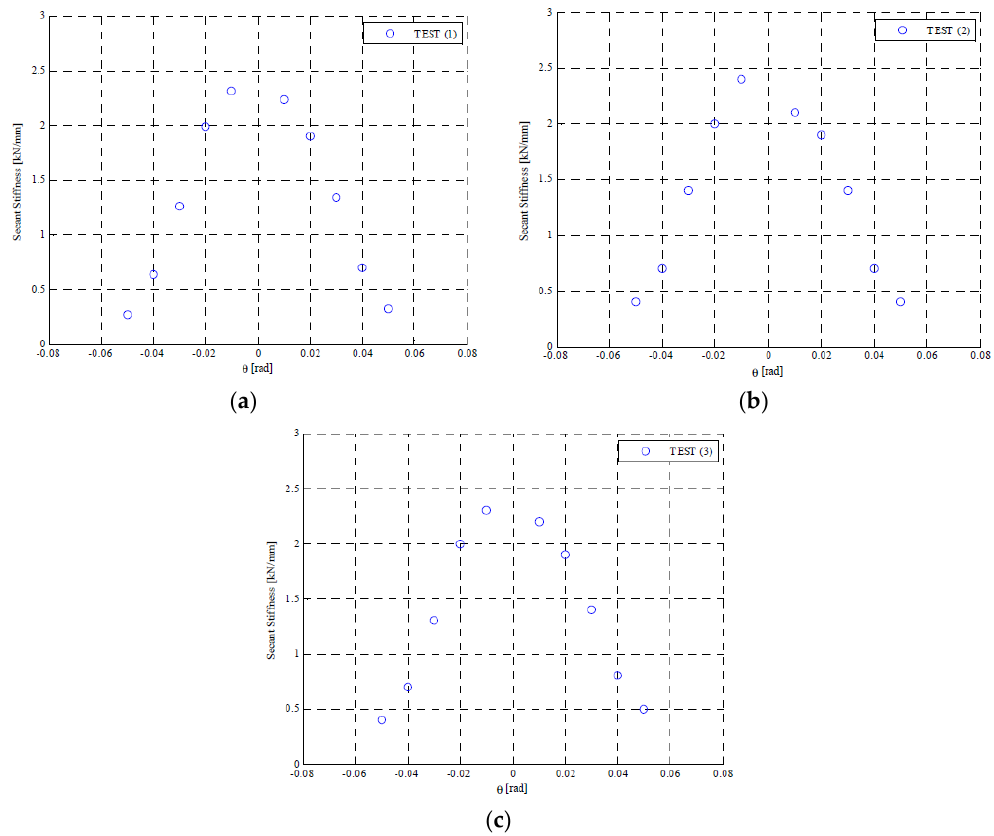
Figure 8. ( a ) Secant stiffness vs. rotation curve of test 1, ( b ) Secant stiffness vs. rotation curve of test 2, ( c ) Secant stiffness vs. rotation curve of test 3.